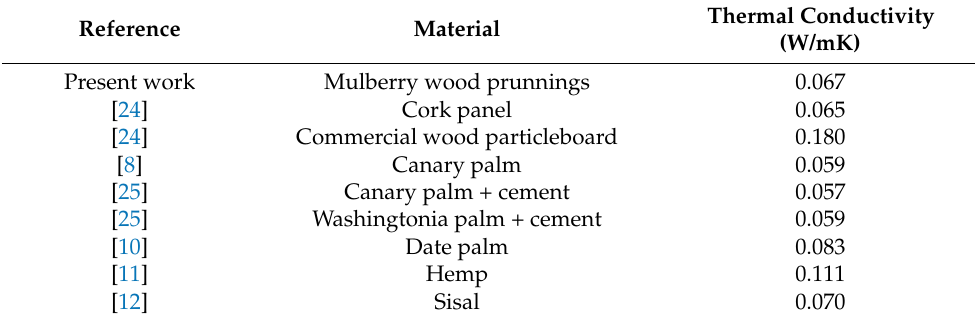
Table 4. Thermal conductivity results obtained by different